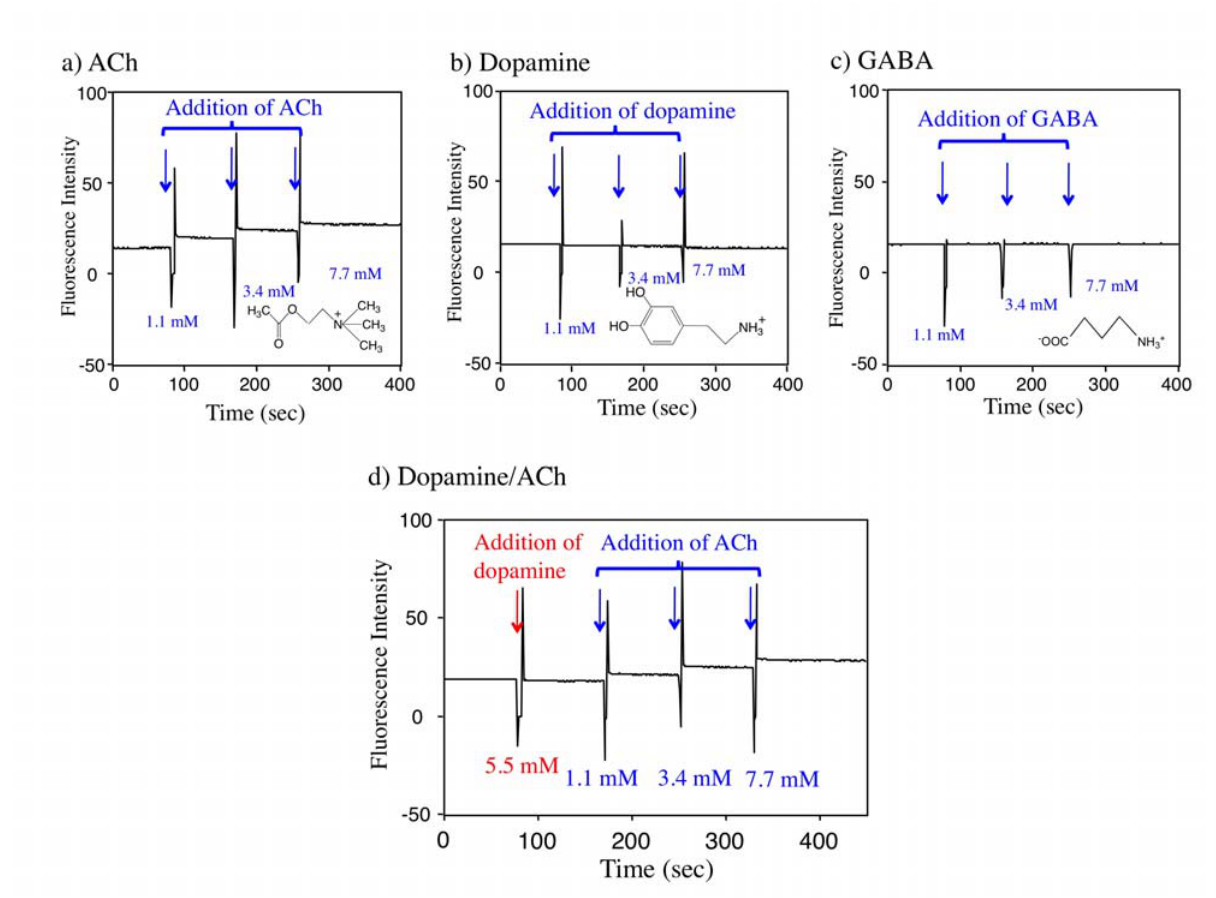
Figure 5. Time course of the fluorescence intensity of Rh800-S[8] solution upon adding (a) ACh, (b) dopamine, and (c) GABA. (d) Changes in the fluorescence intensity of the Rh800- S[8] solution by successive addition of dopamine and ACh. Aliquots of the neurotransmitters (350 mM) were added to the Rh800-S[8] solution. Fluorescence intensity was measured at 710 nm with excitation at 600 nm. [Rh800] = 40 nM, [S[8]]/[Rh800] =